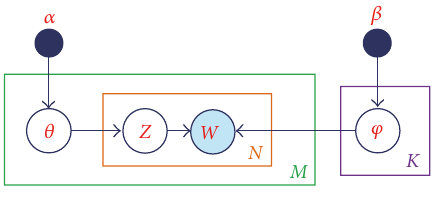
Figure 7: LDA graphical model.